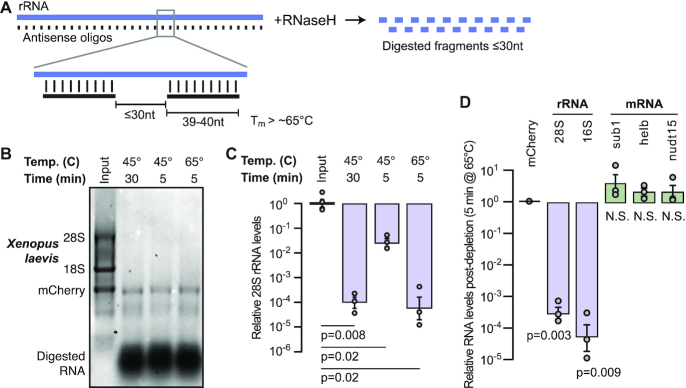
(A) Schematic of rRNA depletion strategy using 39–40 nt antisense oligos spaced ≤ 30-nt apart. (B) X. laevis stage 0 total RNA (input, lane 1) and with rRNA depletion using different reaction conditions visualized on a 1% formaldehyde 1.2% agarose gel. In vitro transcribed mCherry mRNA was spiked into the input RNA prior to digestion. (C) qRT-PCR comparing 28S rRNA levels in X. laevis stage 0 total RNA (input, left) versus depletion conditions normalized to mCherry. P values are from two-tailed paired t tests comparing depleted samples to their corresponding total RNA input. (D) qRT-PCR measuring mCherry-normalized rRNA and mRNA levels in X. laevis stage 0 rRNA-depleted samples divided by levels in untreated samples. P values are from two-tailed paired t tests for each gene comparing depleted samples to their corresponding total RNA input. N.S. = not significant.